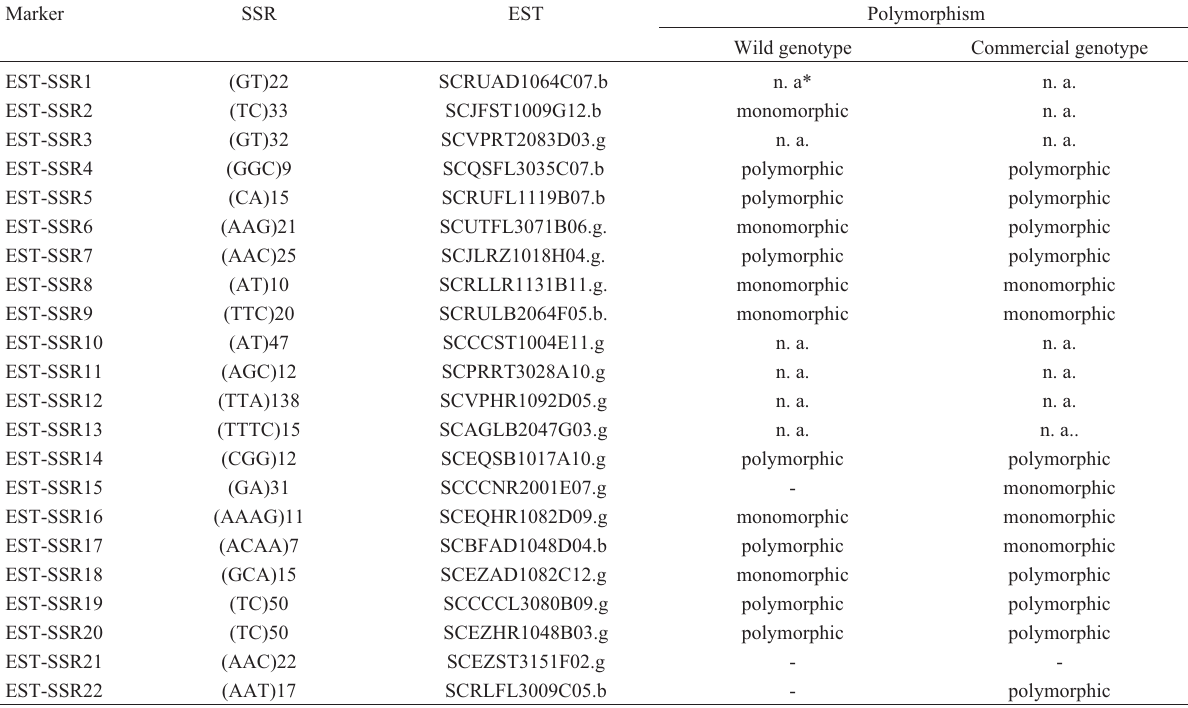
Table I - Polymorphism detected in wild and commercial hybrid sugarcane